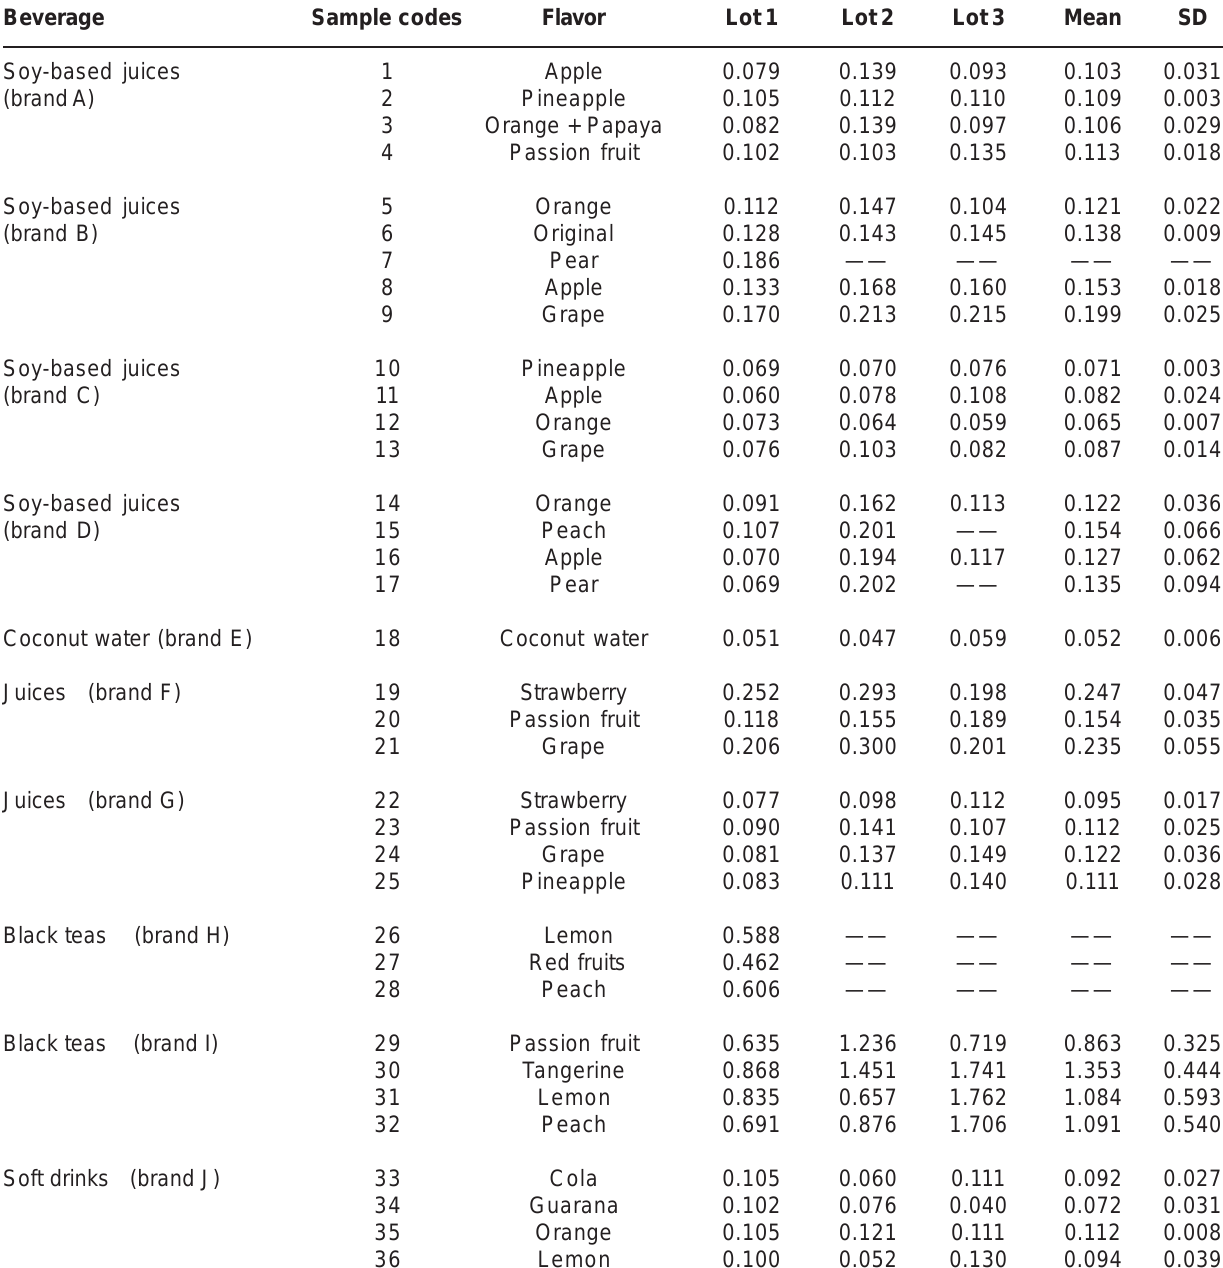
TABLE 1- Fluoride concentration ( µ g/mL) in the different brands and flavors of beverages (tree lots each) consumed by children, Brazil,